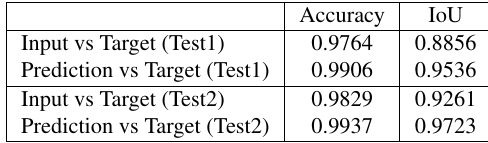
Table 4. Comparison of quality of results using accuracy and